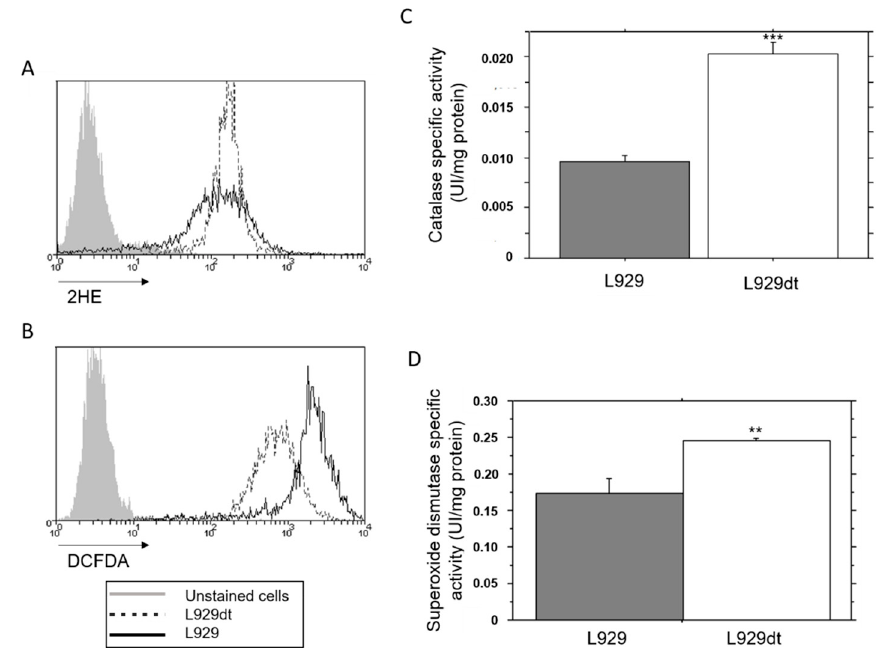
Figure 3. ROS formation, catalase and SOD activity in L929 and L929dt cells at the basal level. ( A ) Detection of superoxide anion by oxidation of dihydroethidium (2HE) and ( B ) oxidation of 2 ′ ,7 ′ -dichlorodihydrofluorescein diacetate (DCF-DA) at the basal level in L929 (solid histogram) or L929dt cells (dashed histogram) were analyzed by flow cytometry. ( C ) Catalase specific activity was measured in cell homogenates as described in Materials and Methods. n = 3, ***, p < 0.001. ( D ) Mn-superoxide dismutase specific activity of L929 and L929dt cells in basal state was measured by spectroscopy, as indicated in Material and Methods. n = 3. ** p < 0.01.